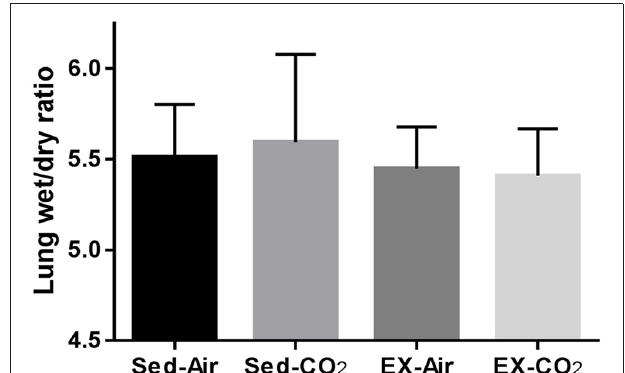
FIGURE 4 | Effects of HH on pulmonary fluid accumulation after 1 month of exercise and CO 2 exposure. Results are following exposure to atmospheric pressure equivalent to 25,000 ft elevation for 24h. Sed-air ( N = 8), sed-CO 2 ( N = 8), ex-air ( N = 6), ex-CO 2 (N = 8).